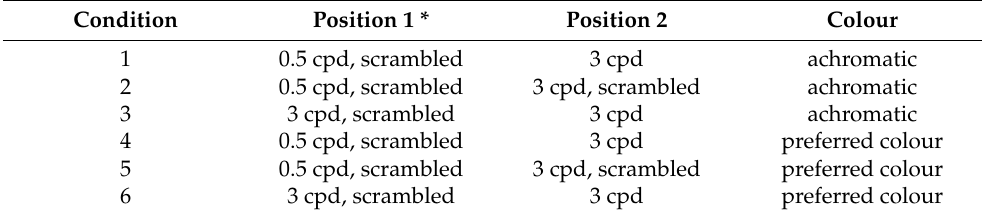
Table 2. Six stimulus pairs used in the P3: dot-probe experiment. Condition Position 1